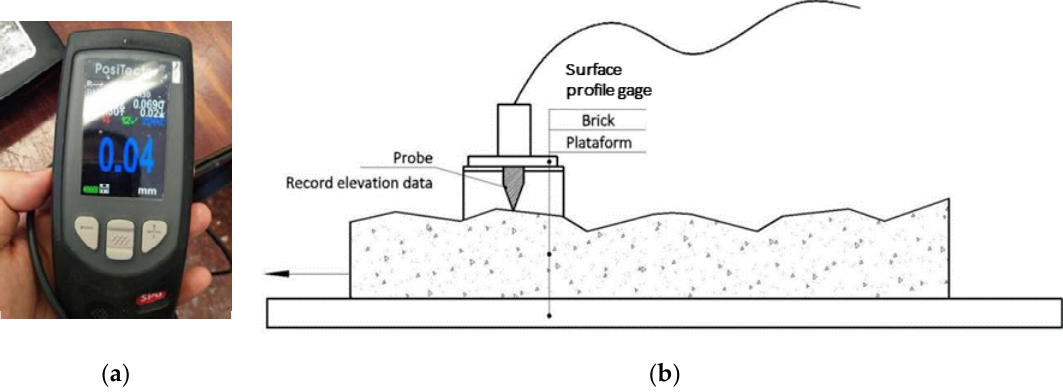
Figure 2. Roughness tests: ( a ) surface profile gage; ( b ) measurement process followed to define surfaces roughness.